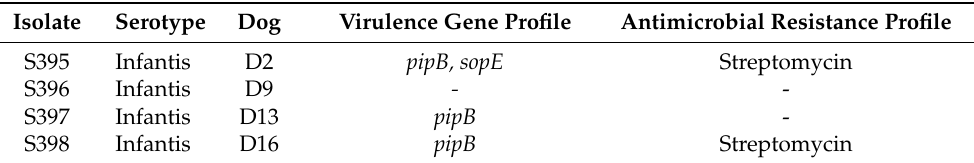
Table 2. Virulence genes and antimicrobial resistance profiles of analyzed and characterized Salmonella spp. strains. Isolate Serotype Dog Virulence Gene Profile Antimicrobial Resistance Profile S395 Infantis Streptomycin